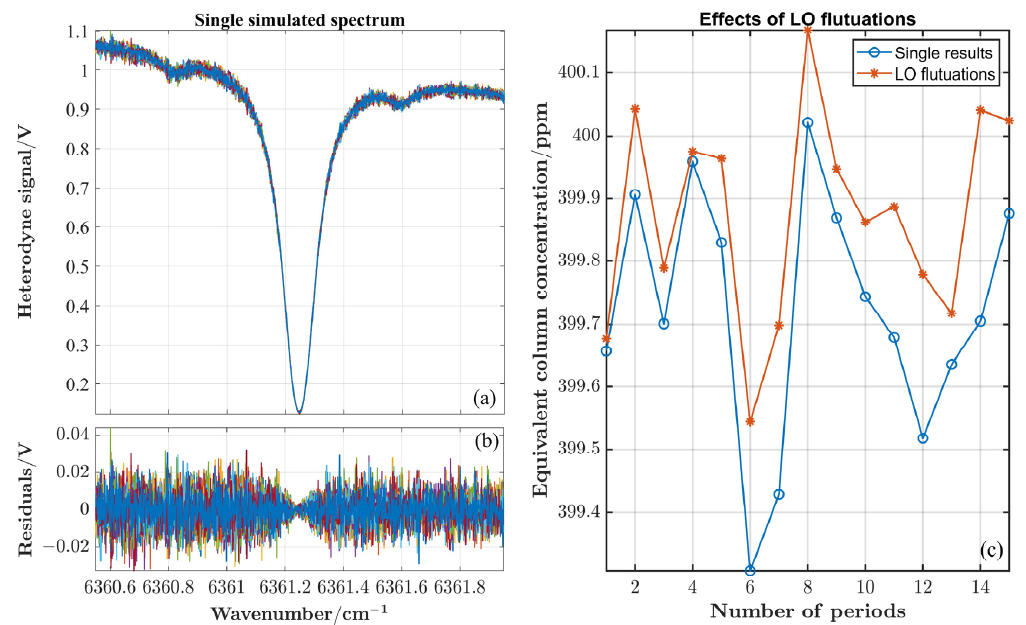
Figure 9. ( a ) The simulated multiple heterodyne-signals, based on the actual SNR and the LO fluc- tuation. ( b ) The residuals between multiple heterodyne-signals. ( c ) Comparison of the influence of the LO fluctuation on the results under the SNR of 100.